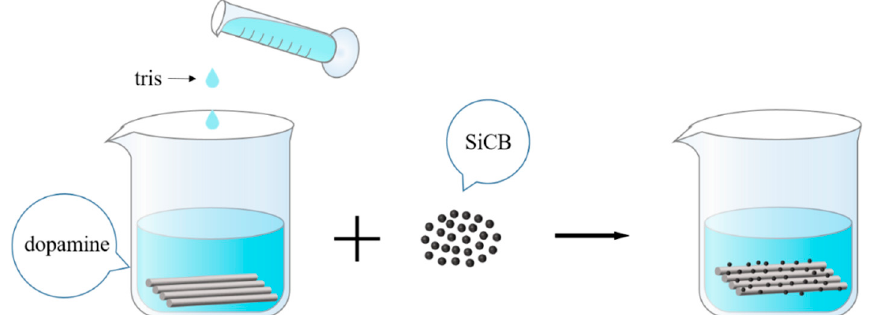
Figure 4. Flow chart of SiCB + PDA synergistic modification of BF.